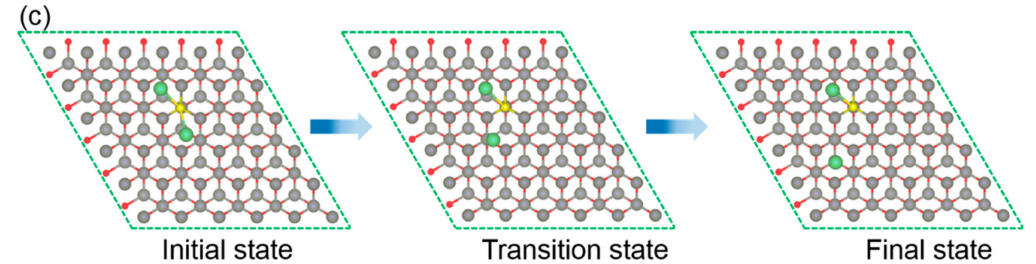
Figure 10. ( a ) The optimized geometrical configuration of Li 2 S 6 -ZnO; ( b ) energy profiles of Li 2 S decomposition on ZnO (101) surface; ( c ) the geometrical configurations of Li 2 S decomposition on ZnO (101) surface.